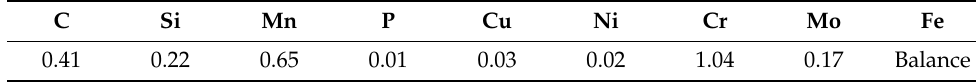
Table 1. Chemical compositions of 42CrMo4 steel (wt.%).